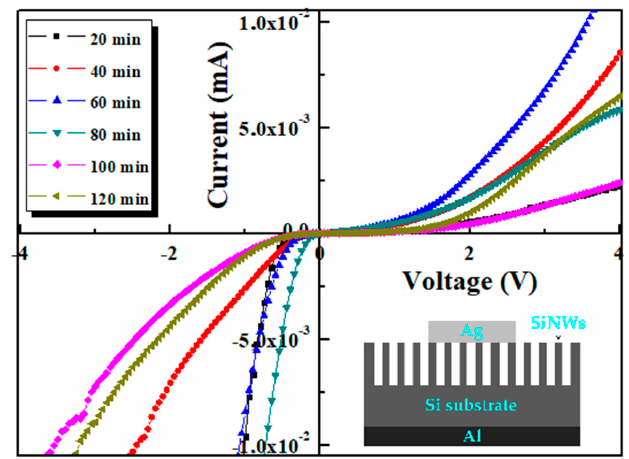
Figure 11. Curves of the as-prepared heterojunction based on SiNWs synthesised at various etching times. The inset displays a schematic illustration of Ag/SiNWs/Si/Al device.